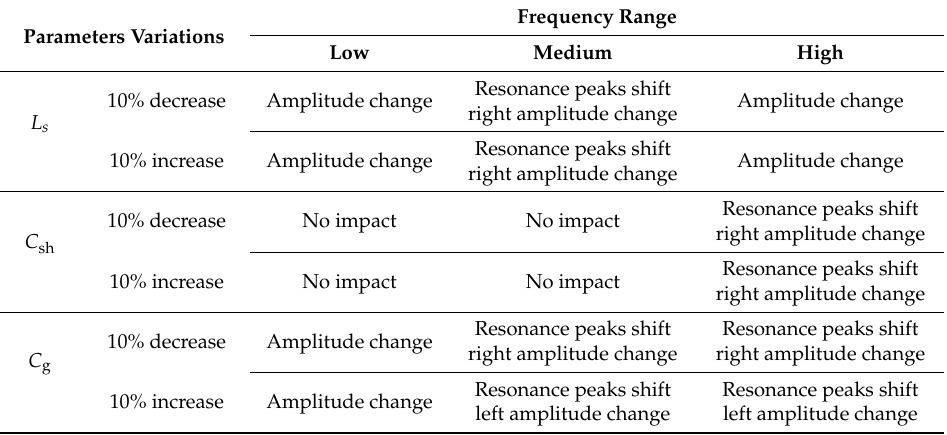
Table 4. The summary of effects of different parameters on FRA signature